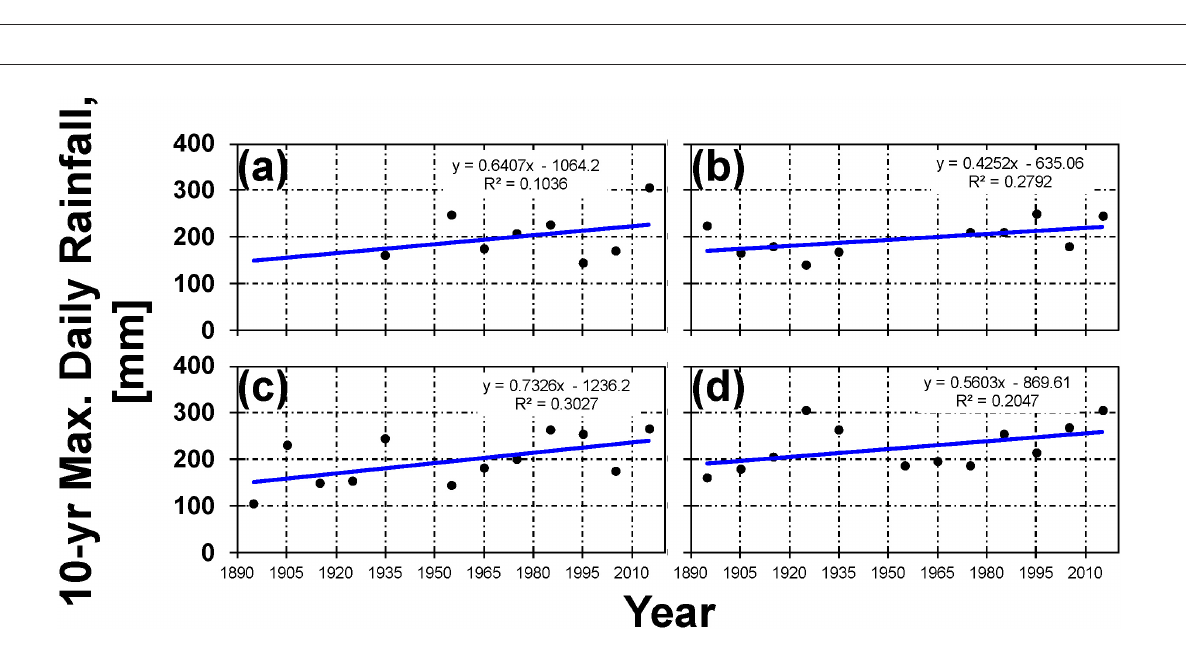
FIGURE2 Rainfall trends for (a) Crowley, (b) Abbeville, (c) Lafayette, and (d) Grand Coteau in Louisiana.